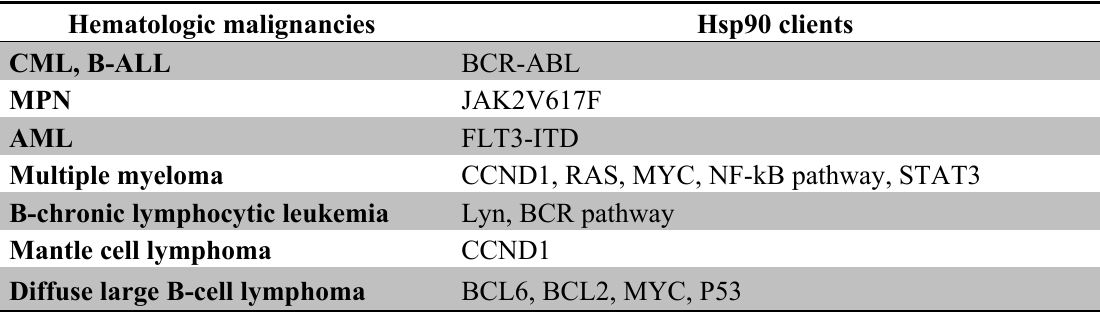
Table 3. HSP90 clients in hematologic malignancies.